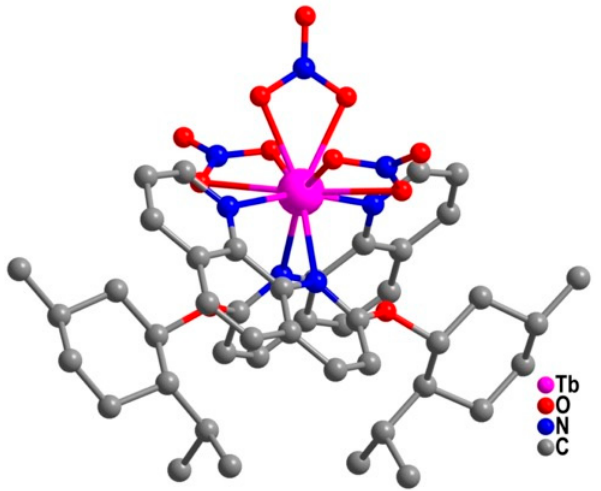
Figure 12. Molecular structure of 19 . Hydrogen atoms are omitted for clarity. The figure is reproduced from Reference [45] with permission from the Royal Society of Chemistry.